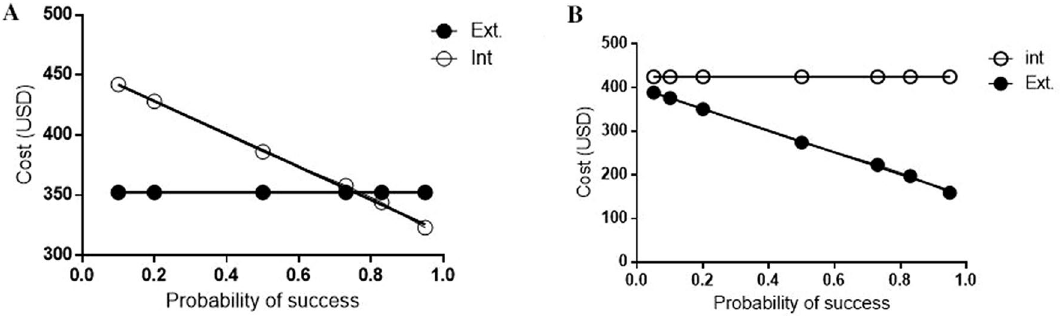
Figure 3. ( A ) One-way sensitivity analysis of extended infusion piperacillin-tazobactam compared with intermittent infusion, varying the probability of clinical success. The extended infusion was kept constant at 19.2% and intermittent infusion varied from 10–95%. ( B ) One-way sensitivity analysis of extended infusion piperacillin-tazobactam compared with intermittent infusion, varying the probability of clinical success. The clinical success of intermittent infusion was kept constant at 22.2% and extended infusion varied from